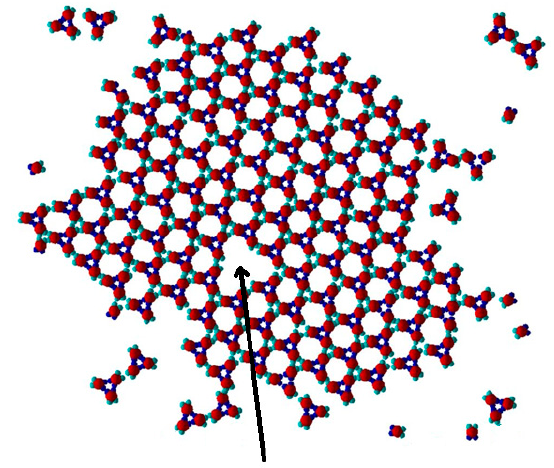
Figure 11. The missing trimer (a vacancy) (see Figure 5h) is shown by an arrow (patch geometry 60–120–60–120 degrees, and anisotropic energetic interactions at T* = 0.10).